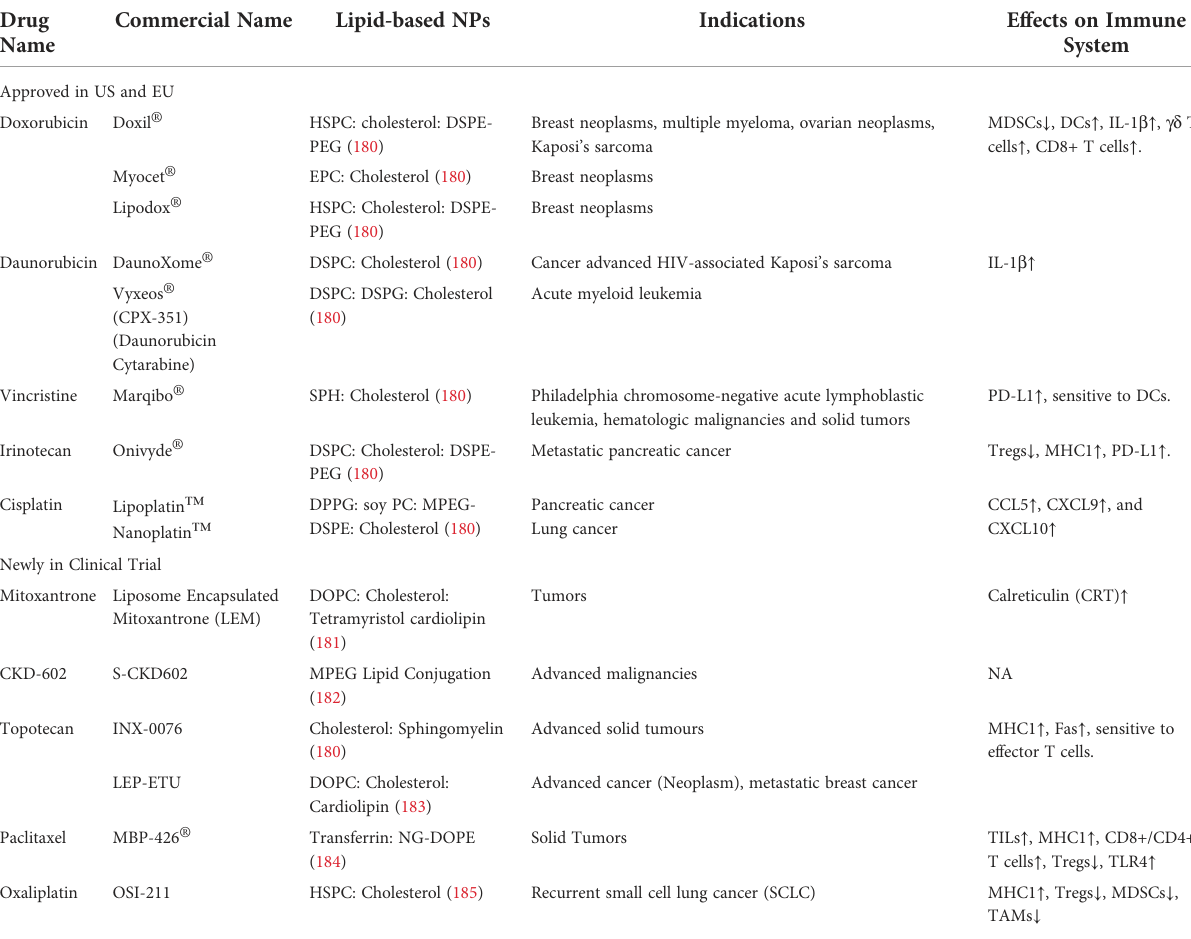
TABLE 1 Cases of immunological regulation of chemotherapies using lipid-based NPs as delivery system. Drug